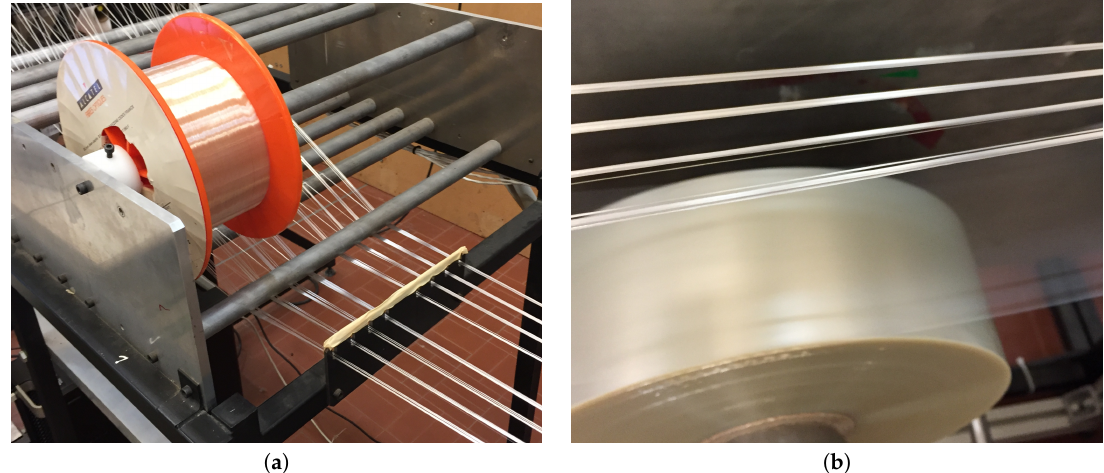
Figure 3. ( a ) Position of the optical fibre spoo. ( b ) View of the components of a strap: PET strand, optical fibre and polymer film.